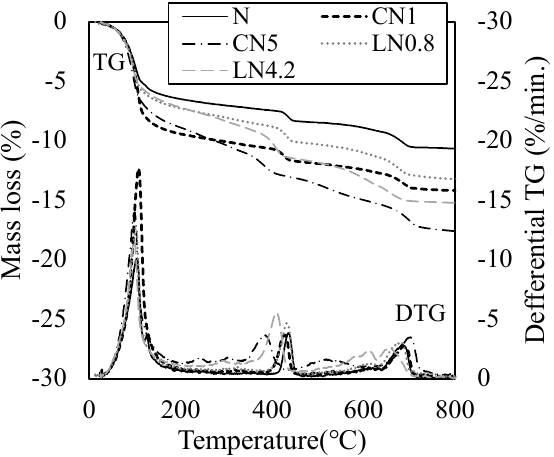
Figure 9. TG/DTG (1 day).